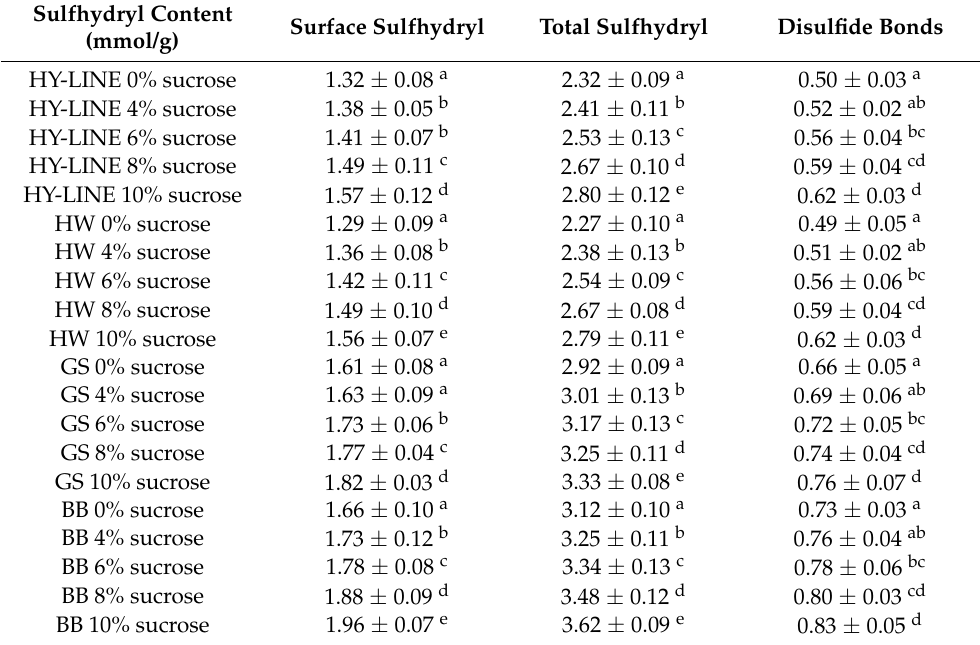
Means with different lowercase letters in the same column are significantly different at p < 0.05. Data are the means ± standard deviations of three replicates. Three replicate samples were measured for each